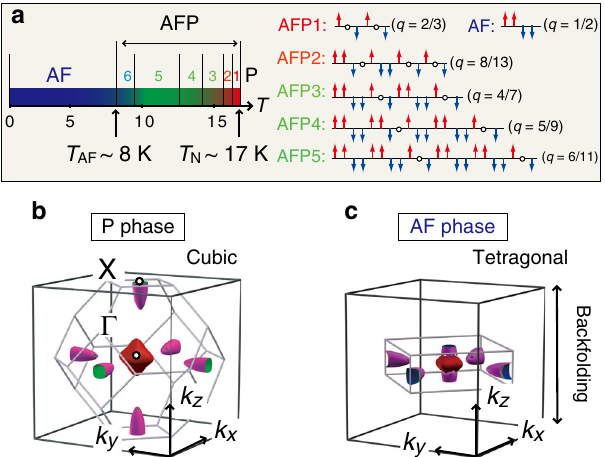
Fig. 1 Magnetostructures and the reconstruction of Fermi surfaces. a Various magnetostructures at zero- fi eld below T N ~17K, which differ in the stacking sequence of the Ising-like ferromagnetic (001) planes (red and blue arrows) with the square wave modulation ( q ) 8,9 . The antiferromagnetic (AF) phase with the double-layer modulation is most favored at low temperature below T AF ~8K while various antiferroparamagnetic (AFP) phases appear as transitional phases. The cruciform 4 f Γ 8 state is the ground state of the 4 f level in the ferromagnetic planes while the 4 f Γ 7 ground state remains in the paramagnetic (P) planes (circles) 23,24 . The crystal lattice is slightly distorted below T N with a shrink along the magnetic moment and q direction 22 . The detailed magnetostructure of AFP6 phase has not been determined yet 10 . b Fermi surfaces (FSs) in Brillouin zone (BZ) of the fcc lattice and c the folded FSs in the reduced tetragonal BZ under the AF modulation ( q =